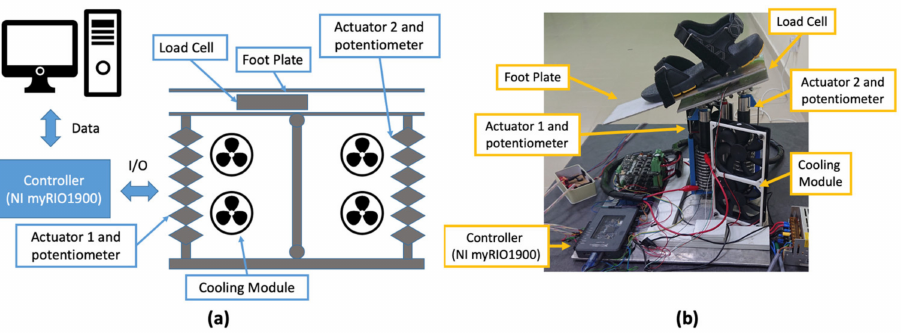
Figure 1. ( a ) Basic schematic of the ankle rehabilitation robot, ( b ) the final working